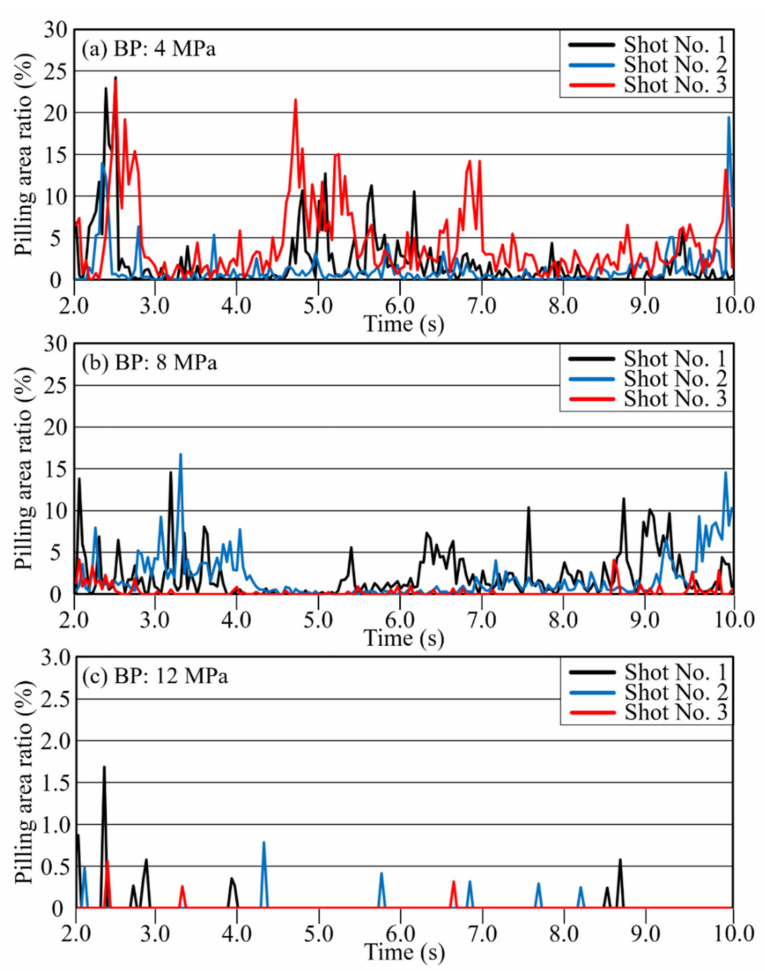
Figure 6. Change curves with time of pilling area ratio under BP of ( a ) 4 MPa, ( b ) 8 MPa, and ( c ) 12 MPa (glass fiber reinforced